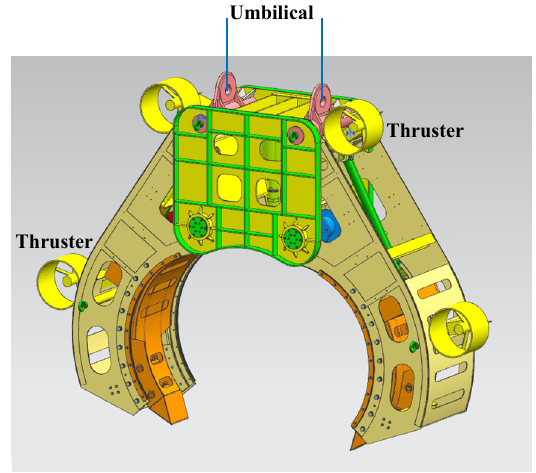
Figure 8. The manipulator with thrusters. The relations between thruster output and manipulator motion are listed in Table 6. Table 6. Relations between the thruster output and the motion of the manipulator. Freedom of